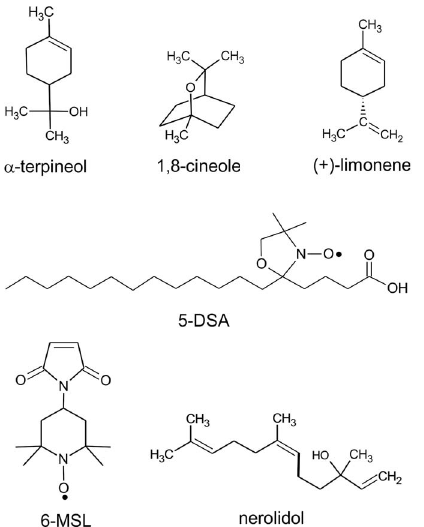
Figure 1. Chemical structures. The four terpenes and the spin labels 5-DSA and 6-MSL used in this